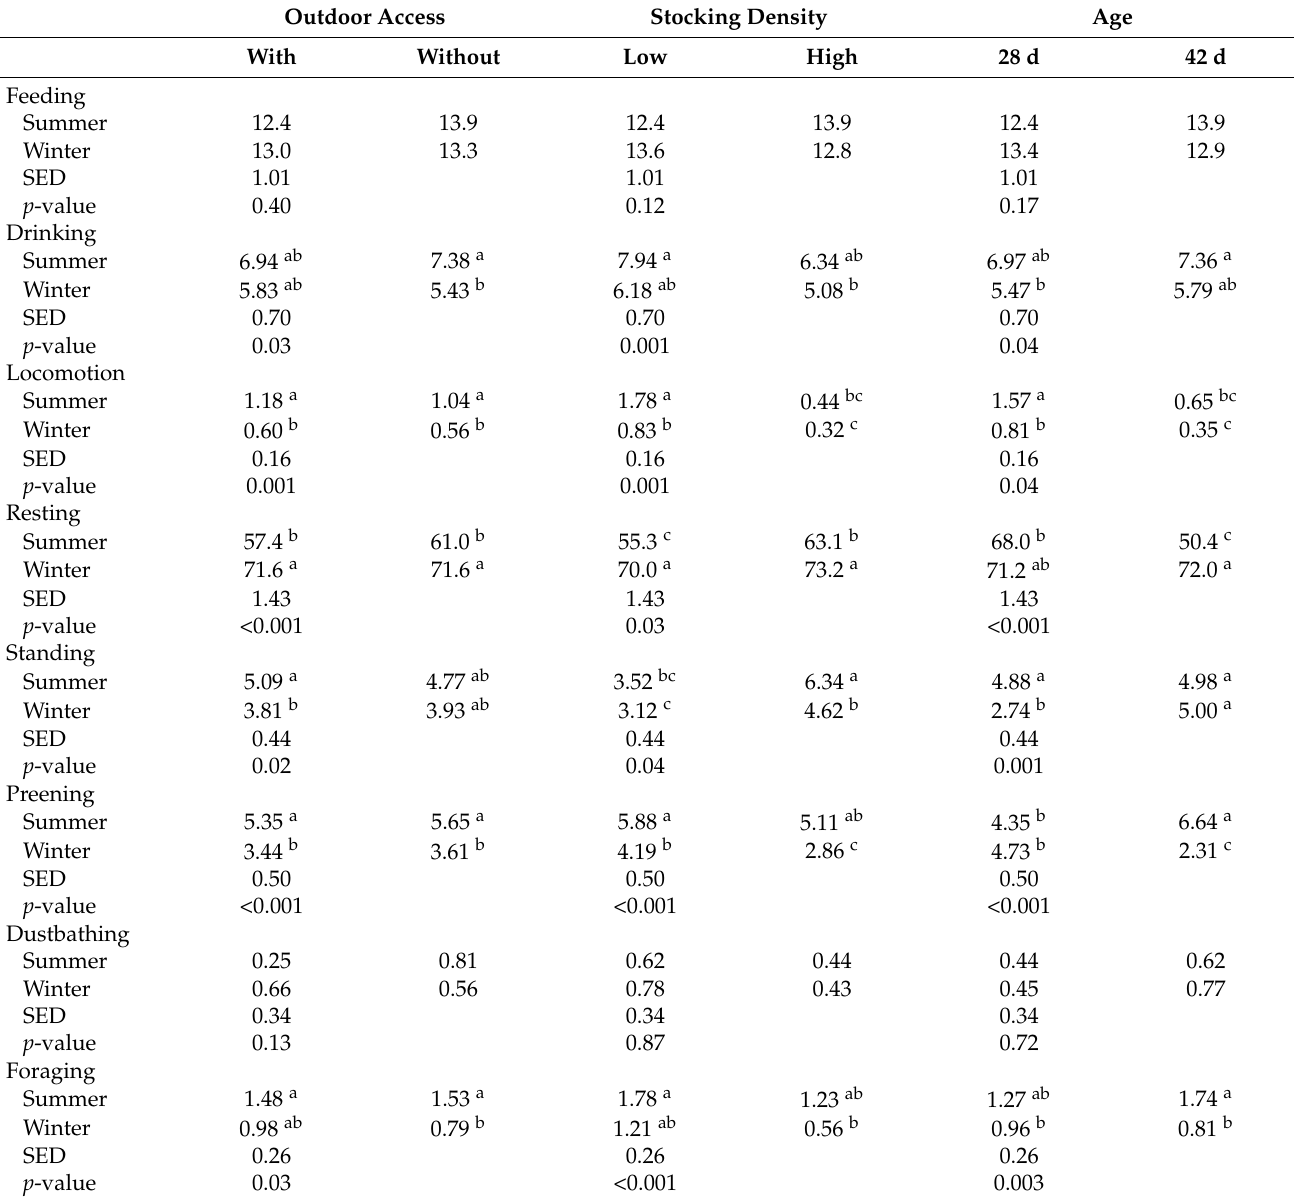
Table 4. The effects of interactions between season and outdoor access, density, and age on the behavior of Cobb500 broilers 1